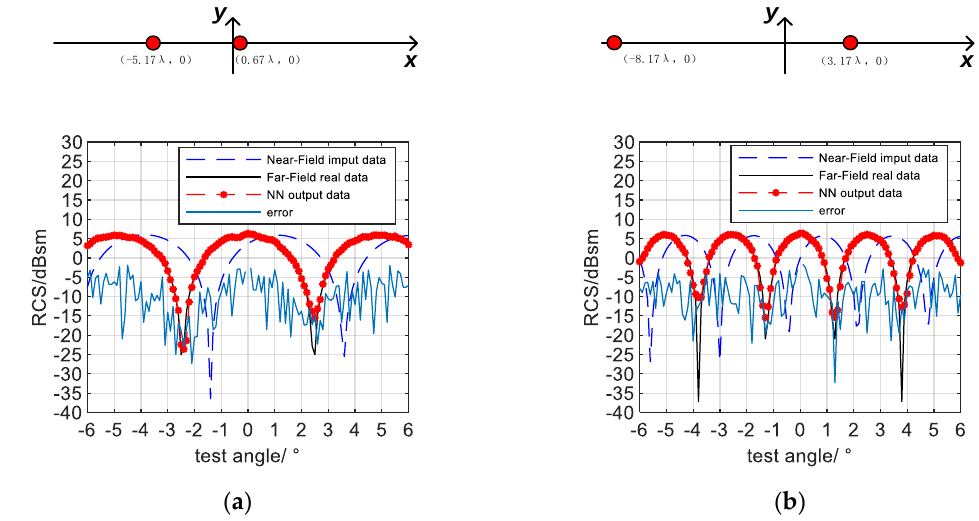
Figure 10. The shape and results of test targets: ( a ) asymmetric sample with little fluctuation; ( b ) asymmetric sample with fluctuation.